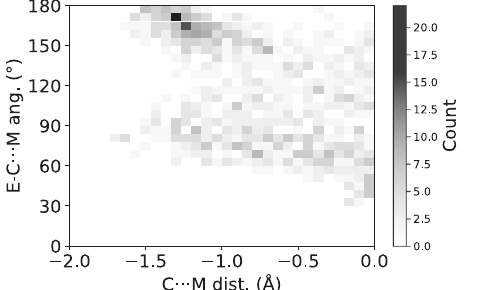
Fig. 3 Geometrical trends in alkaline metal bonding. Angles (E-C···M) distribution as a function of the C···M vdW-normalized distance for M = Li (black), Na (green), K (blue), and Rb (red). E can be any group 13, 14 (except C), and 15 (except N) atom. Source data are provided as a Source Data fi